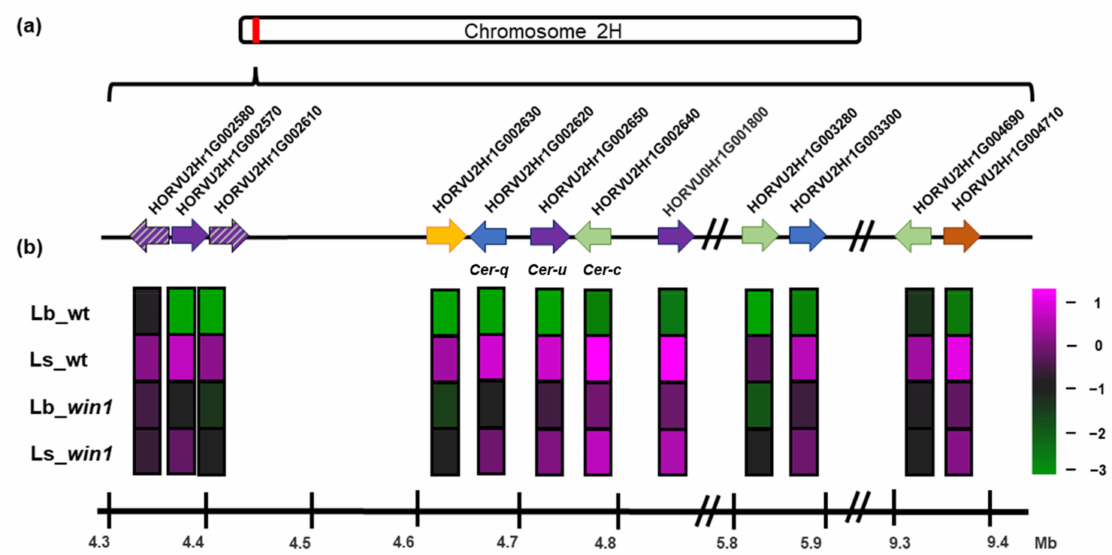
Figure 4. Cer-cqu gene cluster and co-expressed genes. ( a ) Physical map of the relevant region (highlighted in red colour) on barley chromosome 2H according to the Morex v2 assembly [24] Genes related to wax biosynthesis are coloured purple (cytochrome P450), blue (hydrolase), and orange (type-III polyketide synthase). The AdipoR/haemolysin-III-related coding gene is shown in yellow, the O-methyltransferase gene is shown in brown, pseudogenes are shown in striped patterns of corresponding color, and all other genes are shown in black. ( b ) Heatmap of gene expression. The magenta color indicates highly expressed genes, while green corresponds to low expression levels. The magenta-green gradient represents the change in fragments per kilobase of transcript per million mapped read (FPKM)-normalized log2-transformed counts from high to low. lb_ win1 — win1 KO